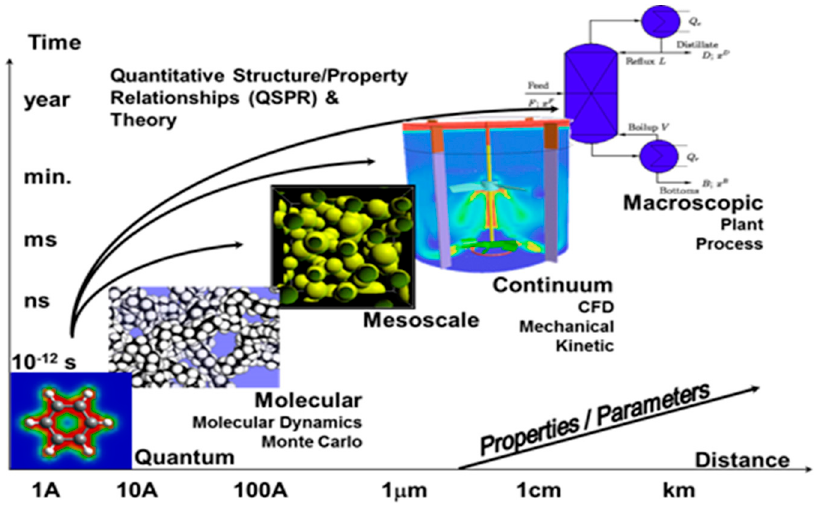
Figure 12. Different scales of quantitative structure-property relationships and theoretical tools applied [113]. applied